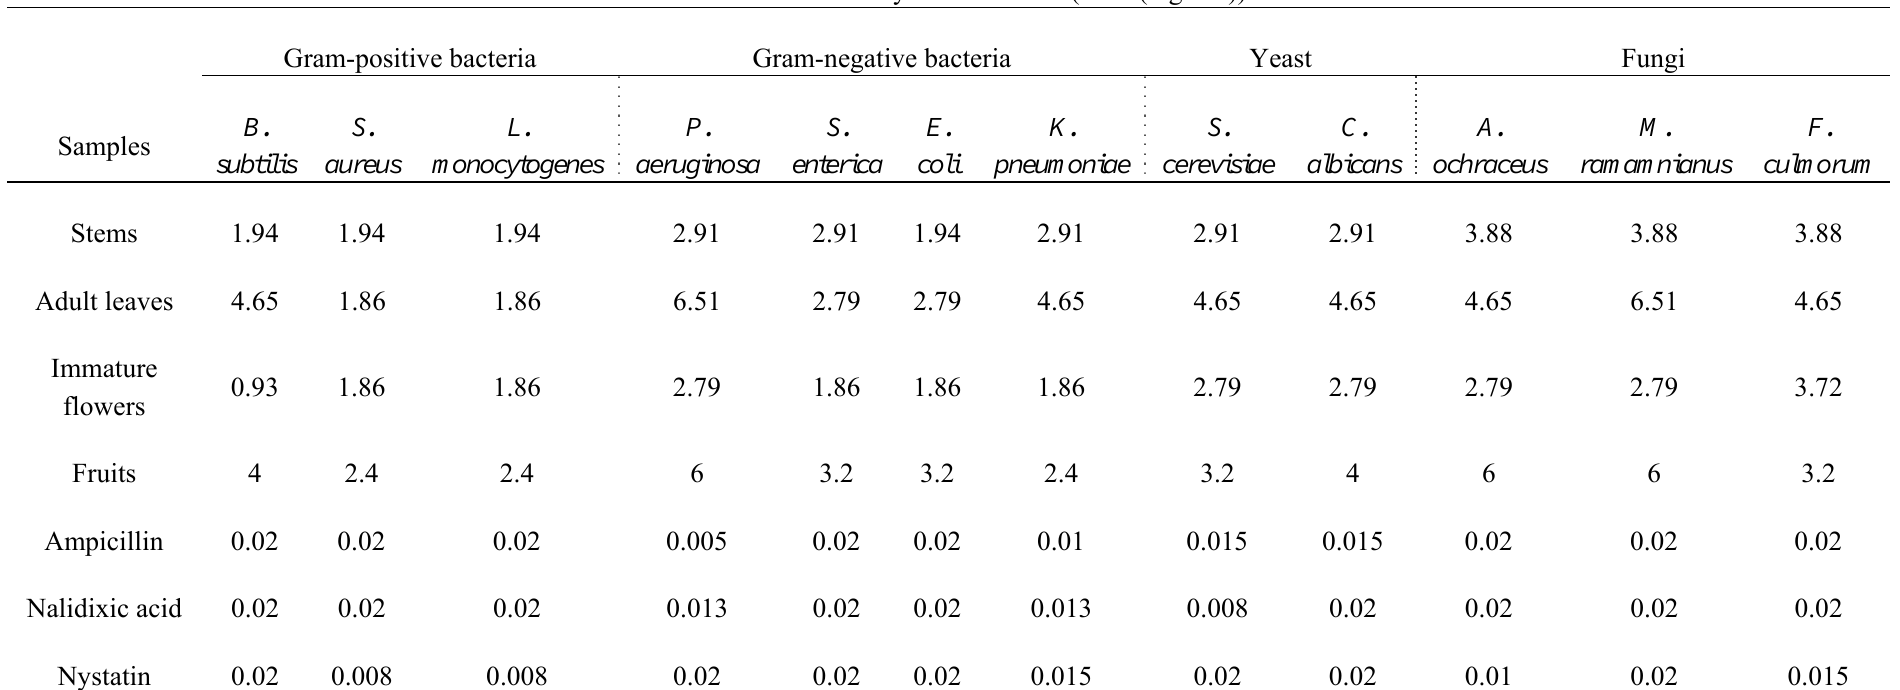
Table 3. Antimicrobial activity (MIC) of the different parts of E. oleosa essential